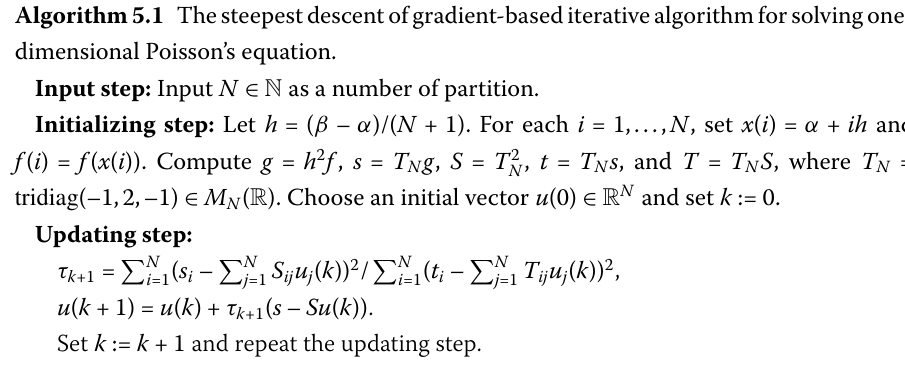
Algorithm5.1 The steepest descent of gradient-based iterative algorithm for solving one- dimensional Poisson’s